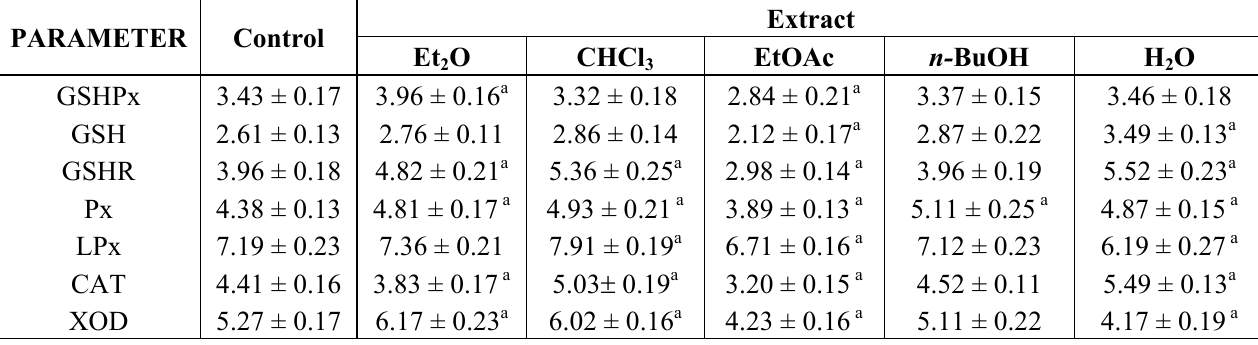
Table 3. Effect of extracts of M. melissophyllum leaves on the biochemical parameters in the liver